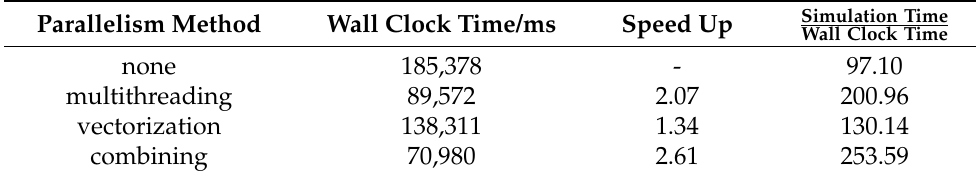
Table 4. The performance results of combining